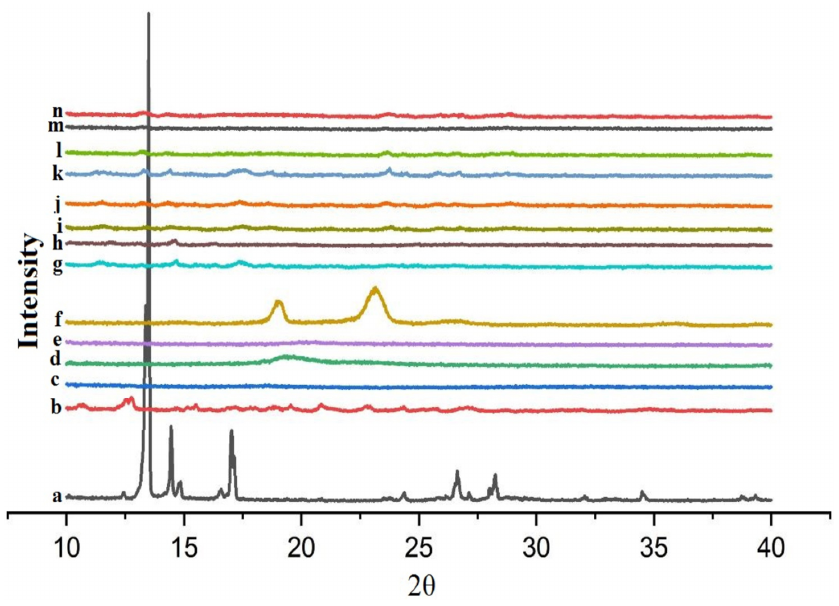
Figure 6. XRD diffractograms of ( a ) DIF; ( b ) βCD; ( c ) HPβCD; ( d ) PVA; ( e ) CMC-Na; ( f ) PXM-188; ( g ) Figure 6. XRD di ff ractograms of ( a ) DIF; ( b ) β CD; ( c ) HP β CD; ( d ) PVA; ( e ) CMC-Na; ( f ) DIF/βCD (1:2); ( h ) DIF/HPβCD (1:2); ( i ) DIF/βCD (1:2) PVA 10%; ( j ) DIF/βCD (1:2) CMC-Na 10%; ( k ) DIF/βCD (1:2) PXM-188 10%; ( l ) DIF/HPβCD (1:2) PVA 10%; ( m ) DIF/HPβCD (1:2) CMC-Na 10%; ( n ) DIF/HPβCD (1:2) PXM-188 10%.